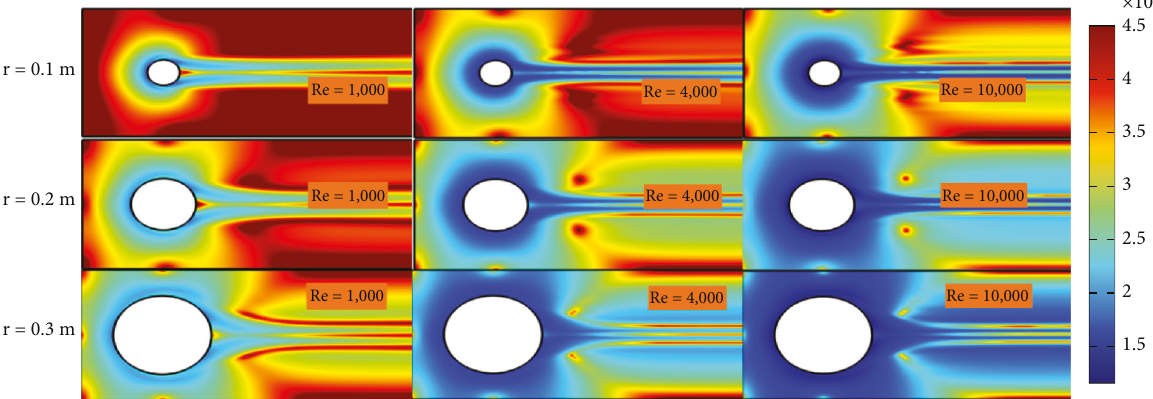
Figure 13: Contours of apparent viscosity around the heated cylinder for n � 0 . 8.